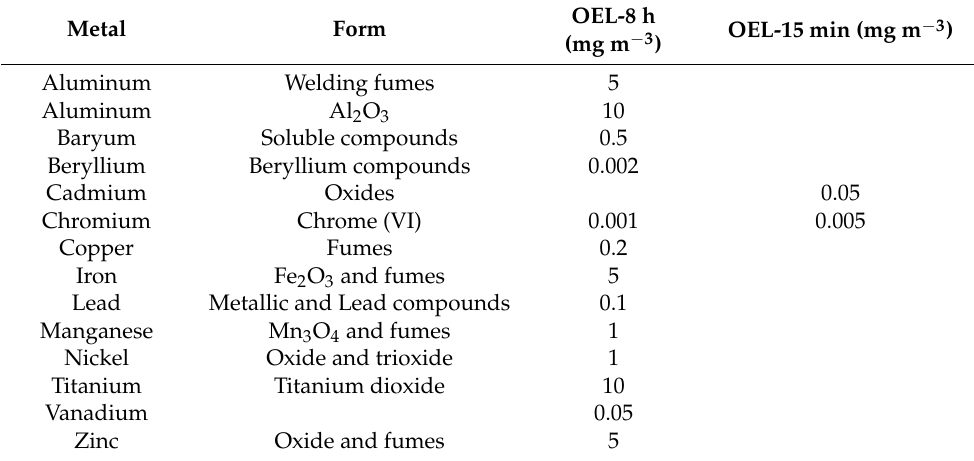
Table A1. Occupational exposure limit values OEL-8 h and OEL-15 min applied in France of the main metals emitted during welding [12,20].